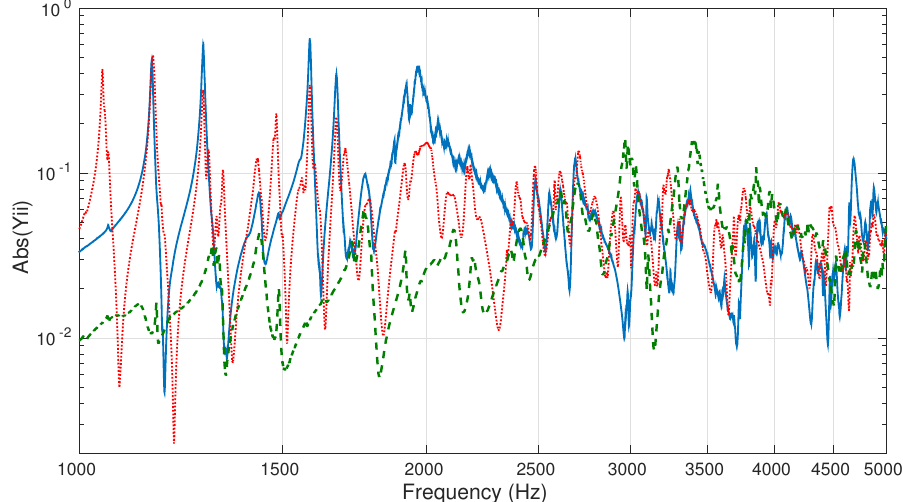
Figure 15. The average mobility measurements for ENV1 (blue line), ENV2 (red dotted line) and ENV3 (green dashed line)